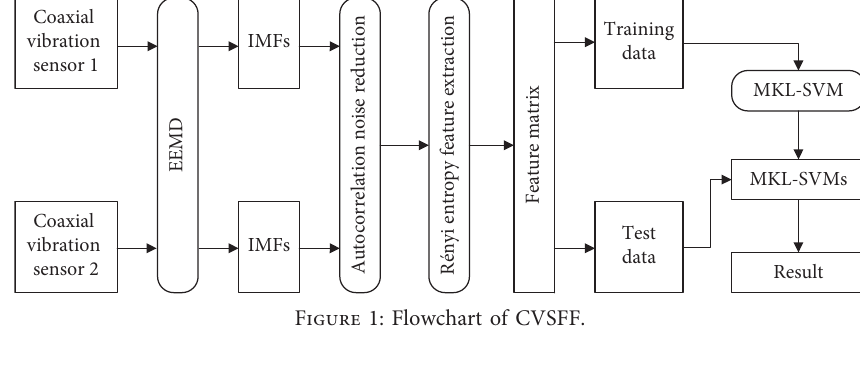
Figure 1: Flowchart of CVSFF.